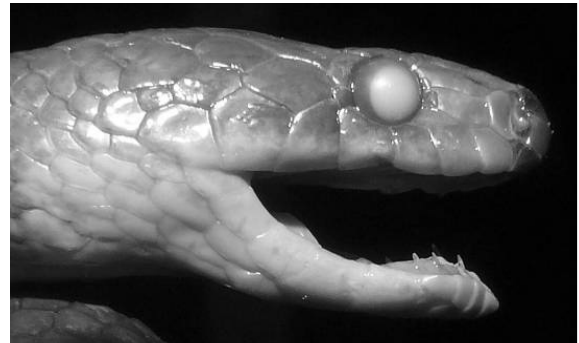
Image 2. Lateral view of head of Lycodon subcinctus subcinctus Boie, 1827 from Great Nicobar. Note the absence of a preocular and the elongated loreal which is in contact with the